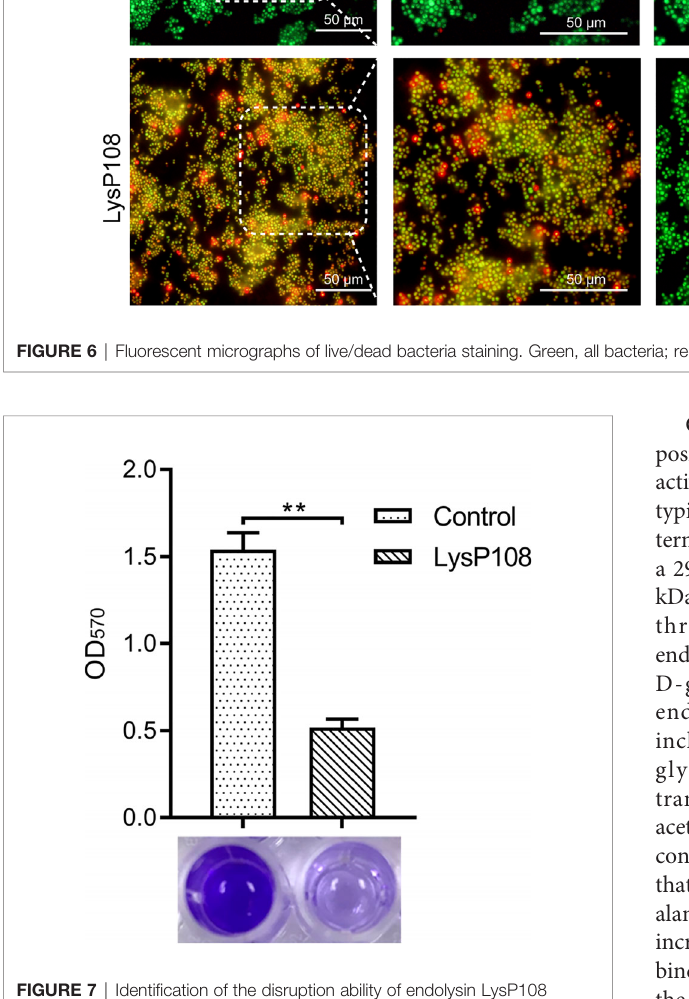
FIGURE 7 | Identi fi cation of the disruption ability of endolysin LysP108 toward bacterial bio fi lm by crystal violet staining. (n=3). ** P <